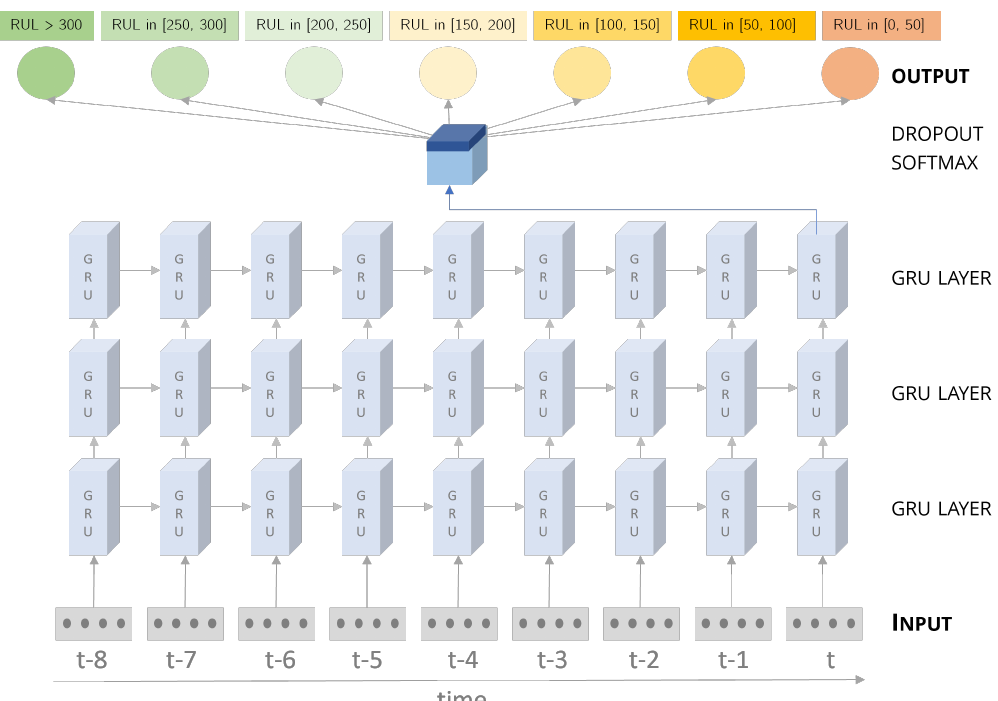
Figure 11. Deep gated recurrent unit (GRU) multiclass classification model. The prognostics is performed using a GRU model that classifies the different health stages of the equipment. Each health stage represents a range of possible remaining useful life values.